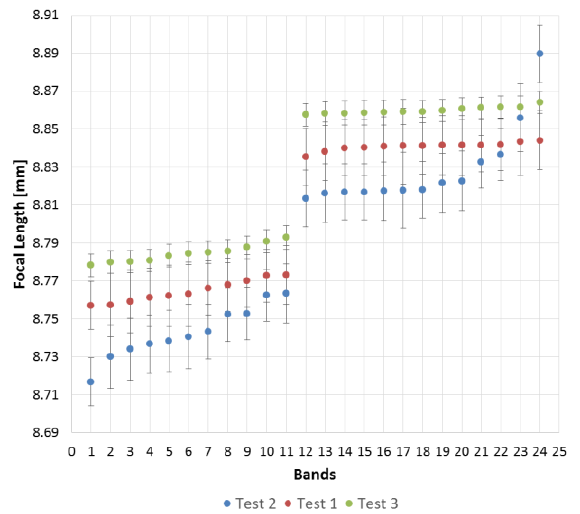
Figure 3 Example of a set of acquired images during a preformed test